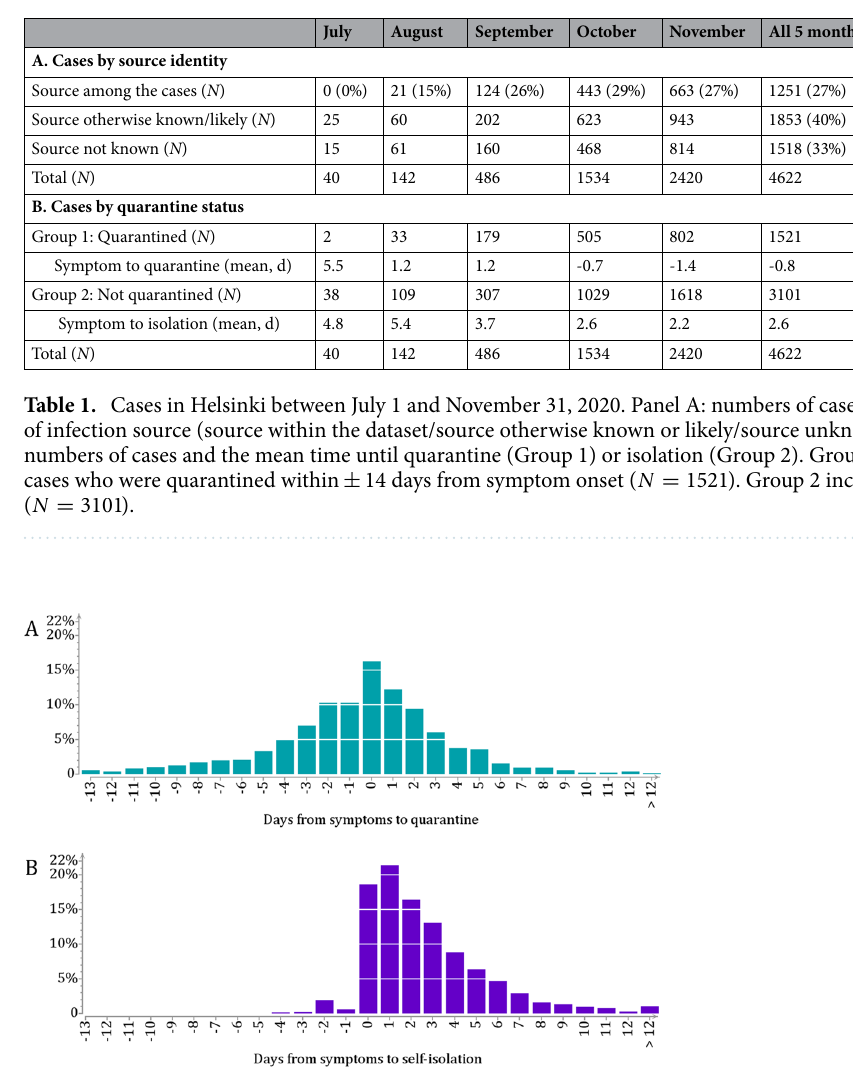
Figure 3. Time from symptoms to quarantine or self-isolation. (A) Time from symptom onset to quarantine onset in 1521 cases initially identified as exposed (Group 1). The mean time lag was − 0.8 days. (B) Self-reported time from symptom onset to isolation in 3101 cases (Group 2). The mean time lag was 2.6